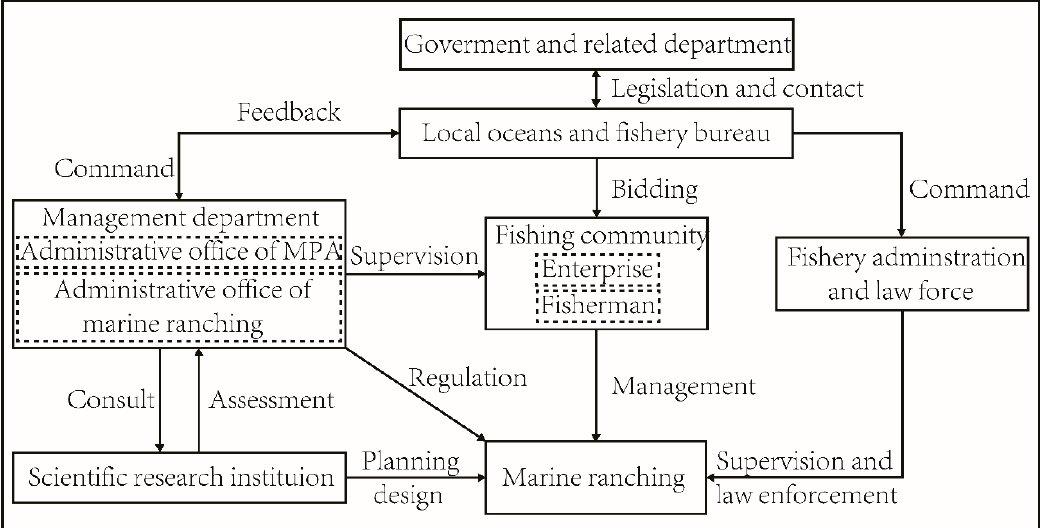
Figure 6. Planning process and implementation of the marine ranching management plan in the Ma’an Archipelago marine ranching pilot [58].